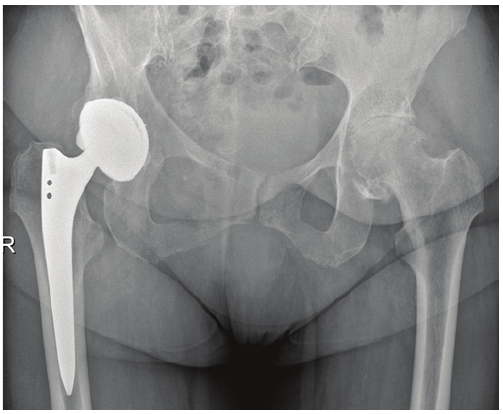
Figure 1: Preoperative X-ray showing the osteoarthritis of left hip.